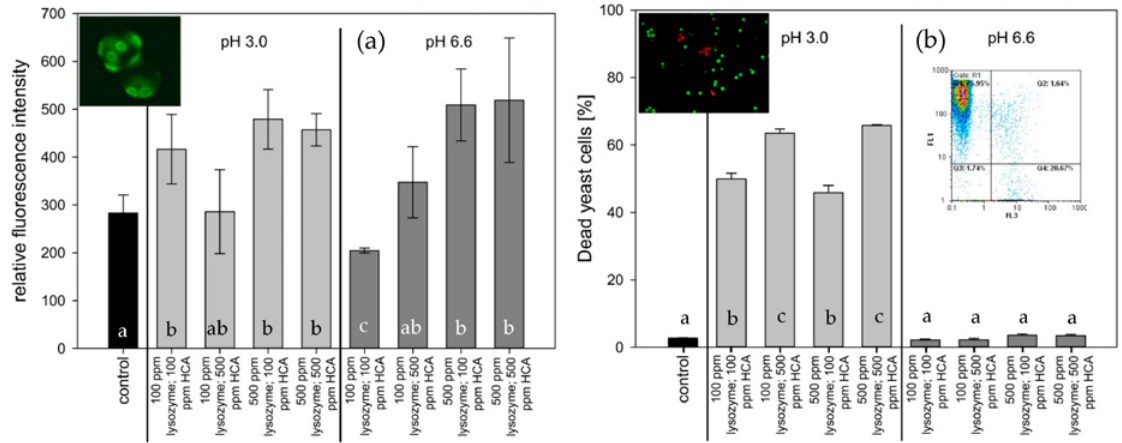
Figure 5. Model fermentations in YPD medium in the presence of lysozyme and hydroxycinnamic acids at different pH conditions (( a ) bud scar fluorescence by flow cytometry, ( b ) yeast viability by flow cytometry). Letters a,b,c indicate statistically significant differences determined by paired t -test.